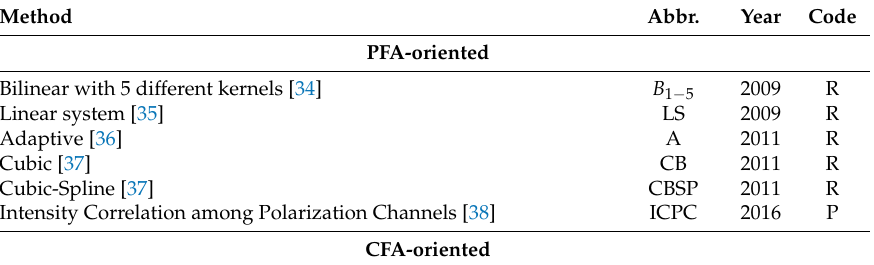
Table 3. Summary of the color, spectral, and polarization filter array (CFA/SFA/PFA) interpolation methods. R, A and P abbreviations mean that the algorithms were Re-coded, Adapted, or Provided by the authors of the original